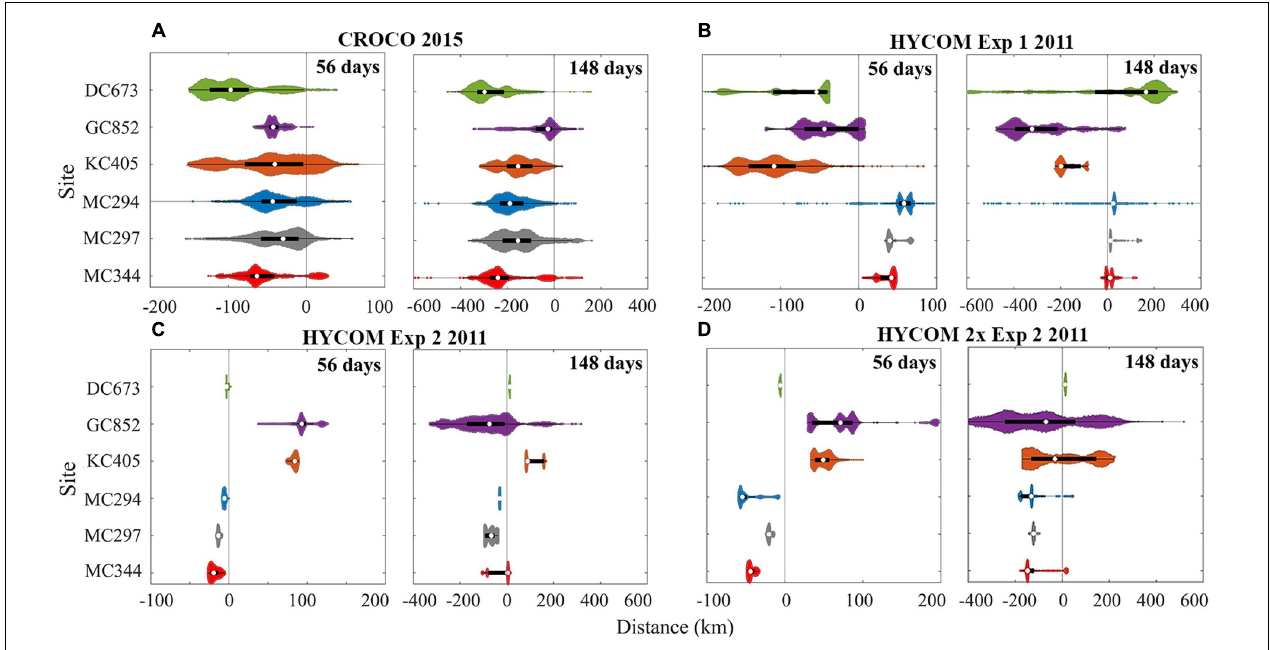
FIGURE 13 | Distribution of horizontal dispersal distances for larval particles after 56 and 148 days. November 2015 release using CROCO (A) , and April 2011 release using HYCOM for Exp1 (B) , Exp2 (C) , and Exp2 with doubled zonal velocity (D) . Positive values represent eastward movement and negative westward. Particles with a vertical displacement larger than 800 m are removed in CROCO result. The definition of color and violin plot is consistent with Figure 5